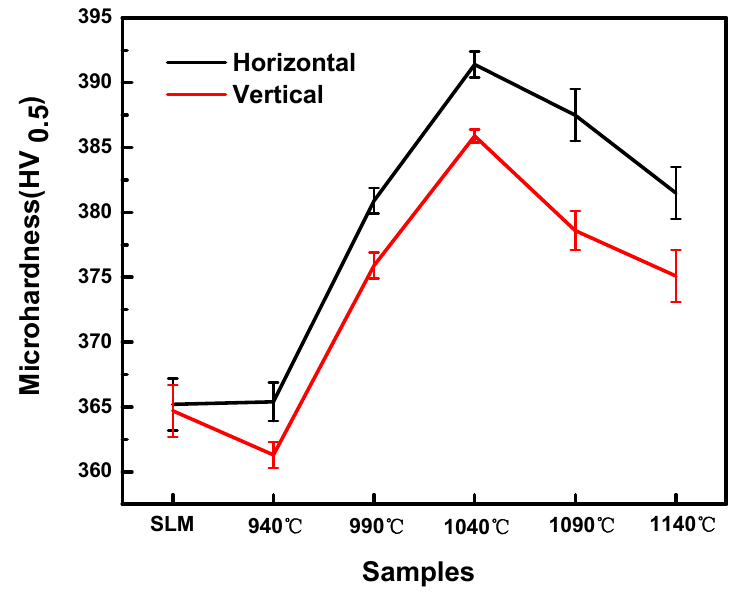
Figure 5. Microhardness of SLM-formed samples and heat-treated samples.